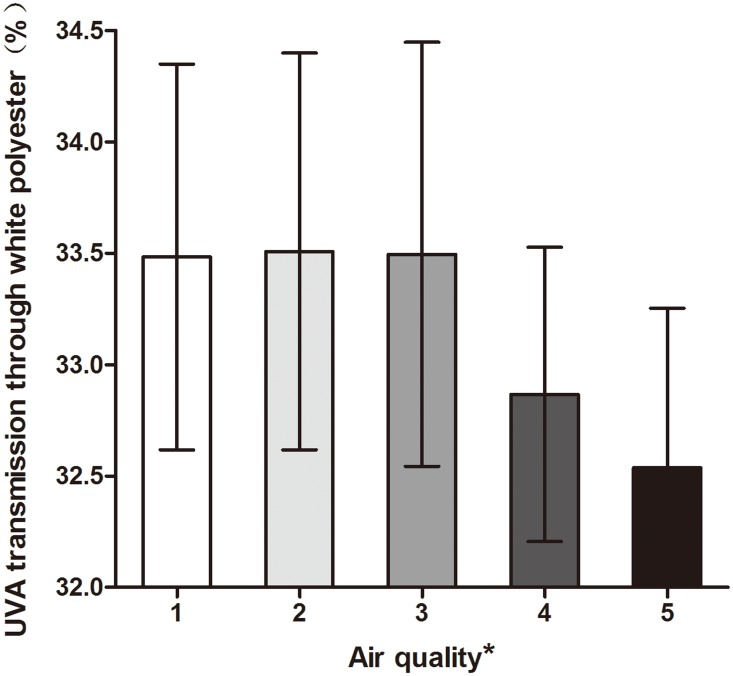
UVA transmission through white polyester with different levels of air pollution.The data on the Y-axis begin at 32%. * The air quality was divided into five levels based on the AQI: 1: 0–50, good; 2: 51–100, moderate; 3:101–150, unhealthy for sensitive groups; 4: 151–200, unhealthy; 5: 201–300, very unhealthy. UVA transmission in the presence of air quality levels 1, 2, and 3 was significantly different from that for levels 4 and 5.